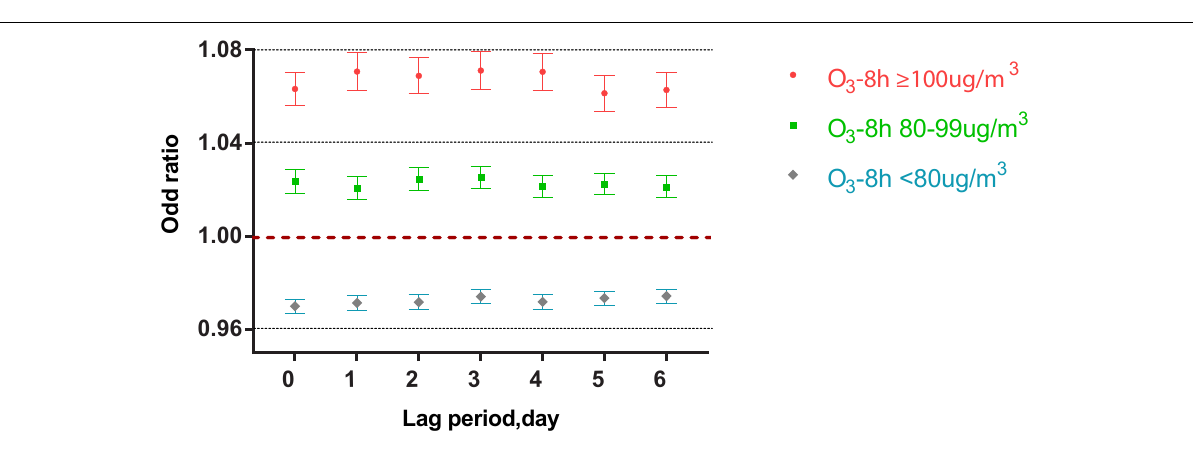
was significant when ozone concentration was higher than 100 µ g/m 3 . When ozone concentration was less than 80 µ g/m 3 , attacks in